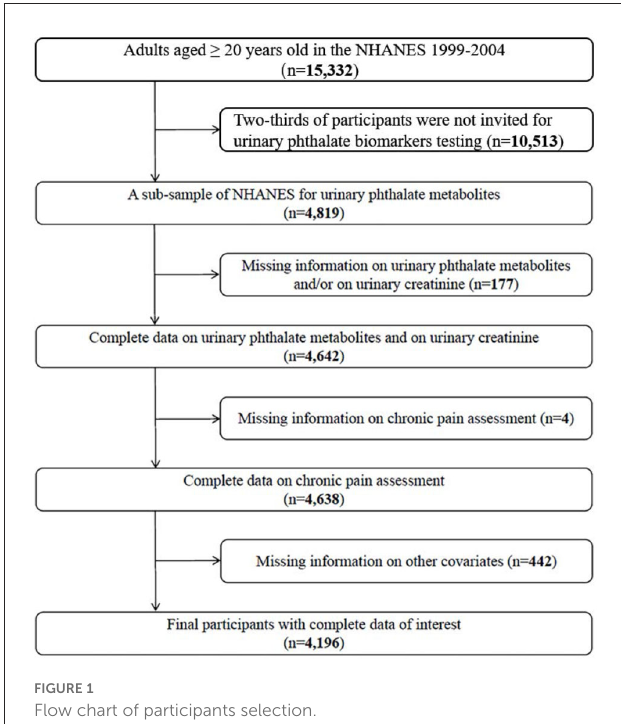
FIGURE1 Flow chart of participants selection.